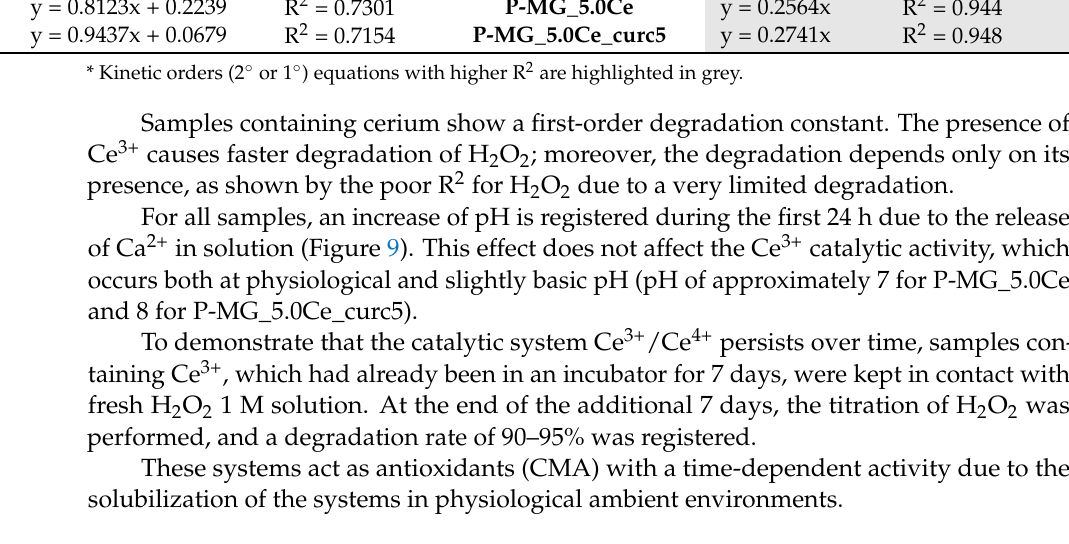
Table 3. Linear equations and kinetic order of degradation in for each sample.